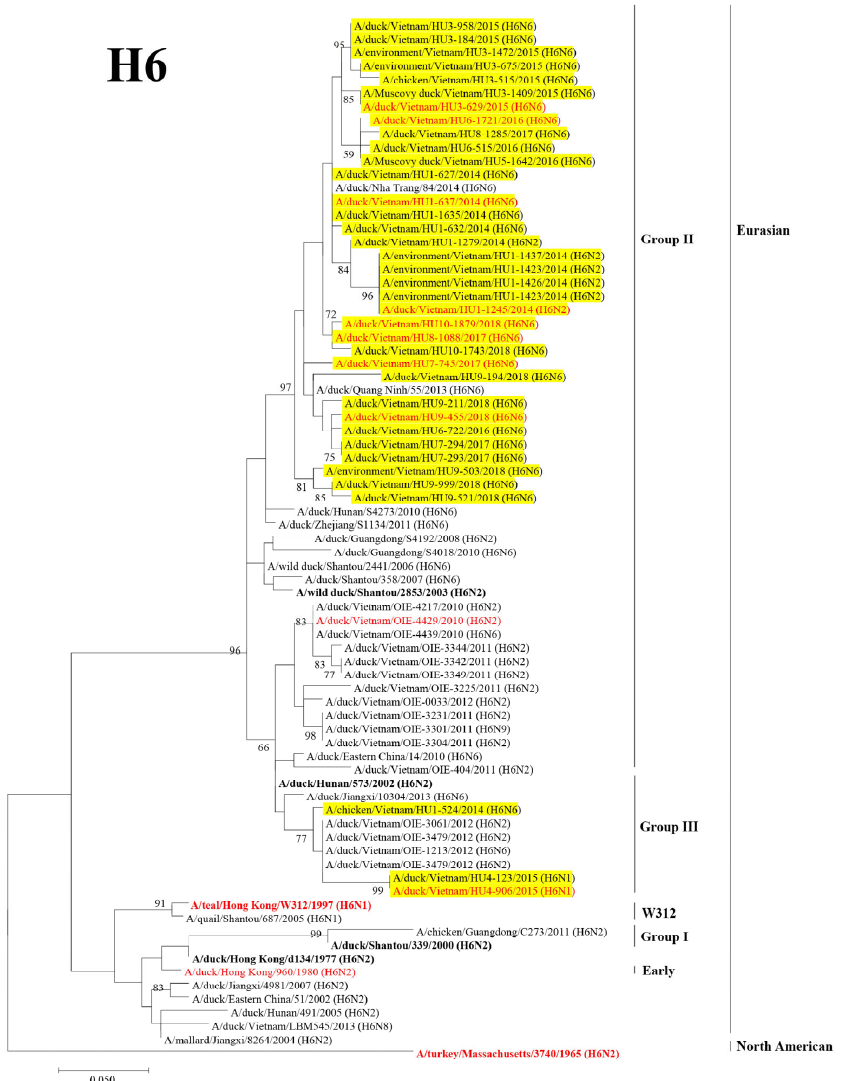
Figure 2. Phylogenetic tree of the HA gene segment of H6 avian influenza viruses. The HA gene segment of the H6 subtype viruses and of the reference strains was analyzed using the ML method using MEGA 7.0 software. The numbers at the nodes indicate the probability of the confidence levels from 1000 bootstrap replicates. The H6 viruses in this study are highlighted in yellow, the representative virus of each sublineage/clade is indicated in bold, and the viruses selected for antigenic analysis are red highlight. The NA gene segments were classified based on previous studies [16,17]. While the classification of N2 NA genes of the H9 LPAIVs and N6 NA genes of the H6 LPAIVs was